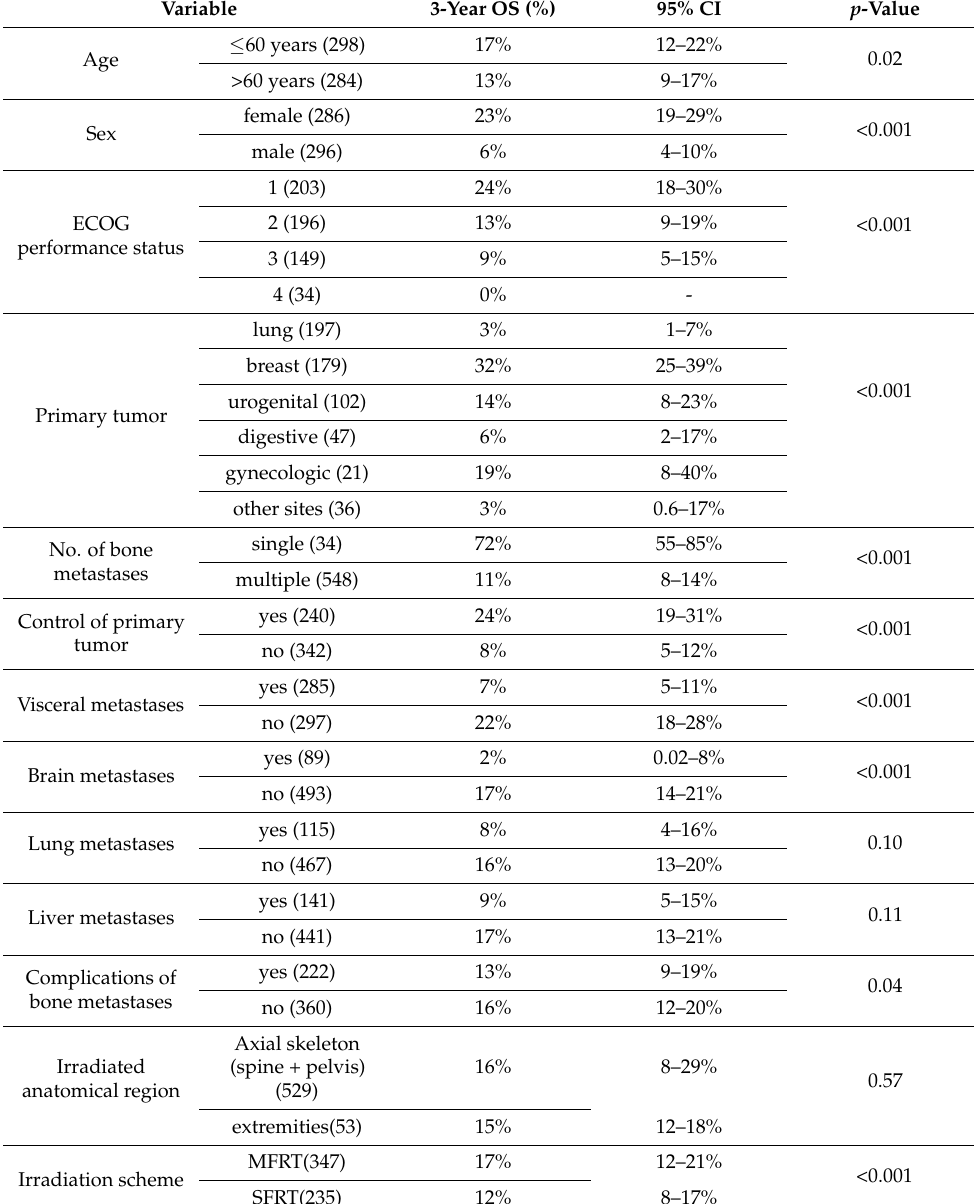
Table 2. Univariate analysis of 3-year overall